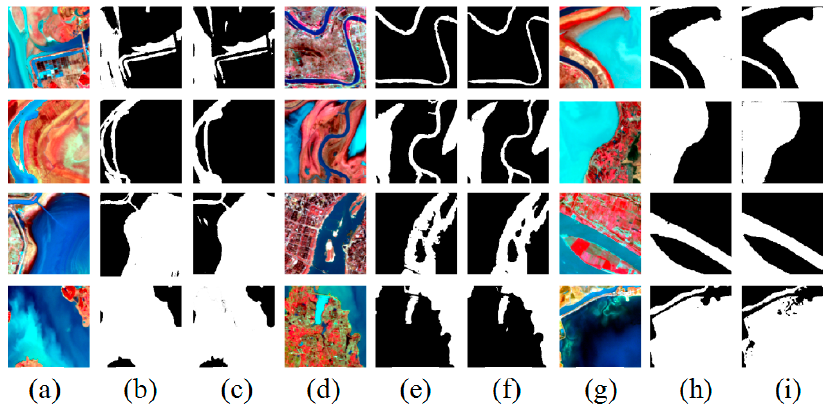
Figure 4. Result of the water body identifications using the DenseNet model. The figure is divided into four rows and nine columns, showing the recognition effects in 12 different regions. Column ( a ), ( d ), ( g ) are the false-color remote sensing images; column ( b ), ( e ), ( h ) are the corresponding ground truths; column ( c ), ( f ), ( i ) are the corresponding model (DenseNet) recognition results.